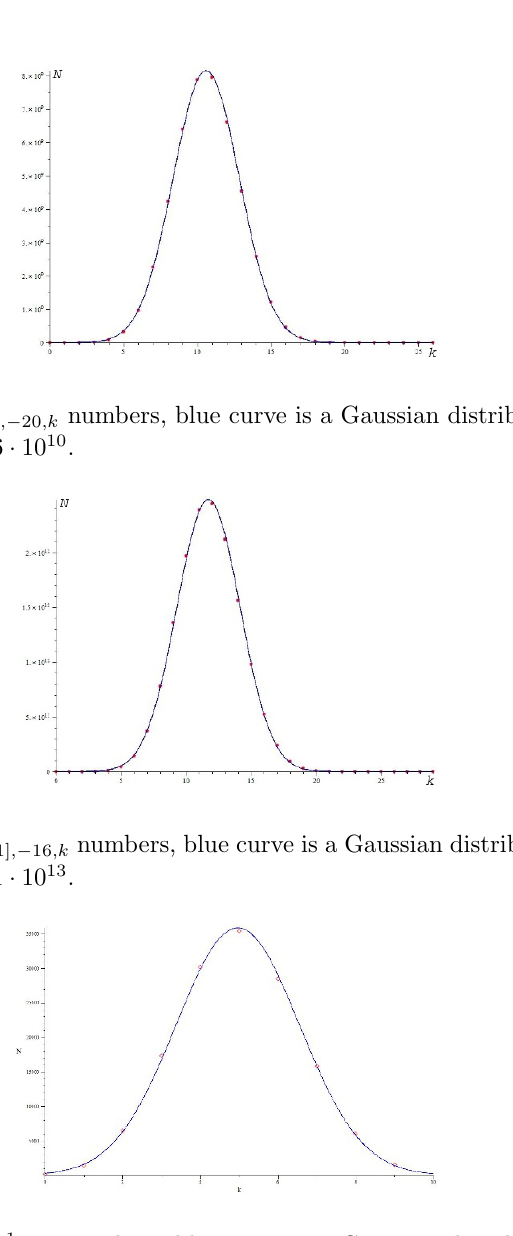
Figure 3 . Red dots are ^ N c =1 numbers, blue curve is a Gaussian distribution with parameters [2] ; (cid:0) 11 ;k (cid:22) = 4 : 96 (cid:27) = 1 : 59 I = 1 : 43 (cid:1) 10 5